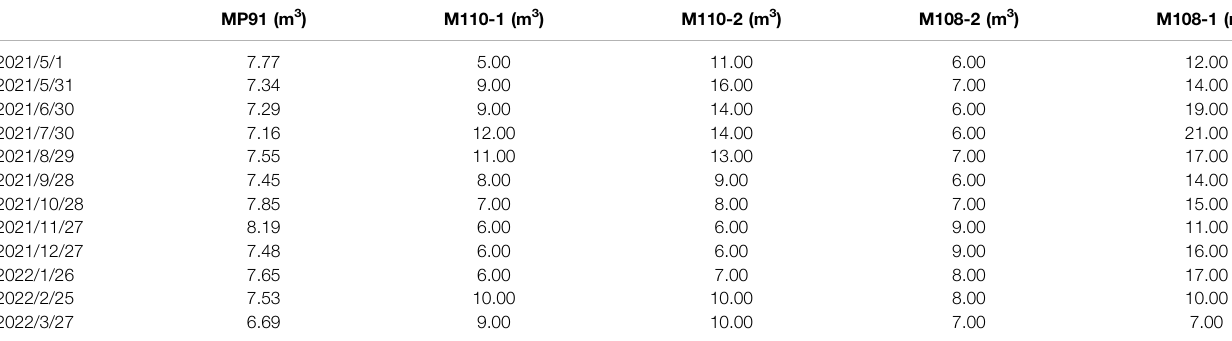
TABLE 1 | Optimizing production measures.